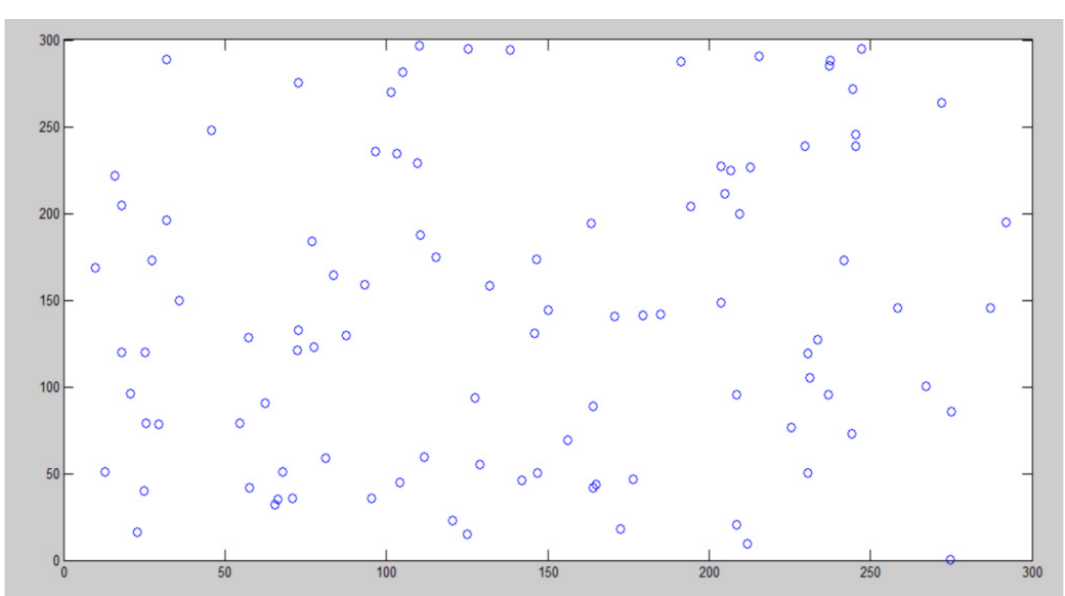
Figure 2. Protocol.